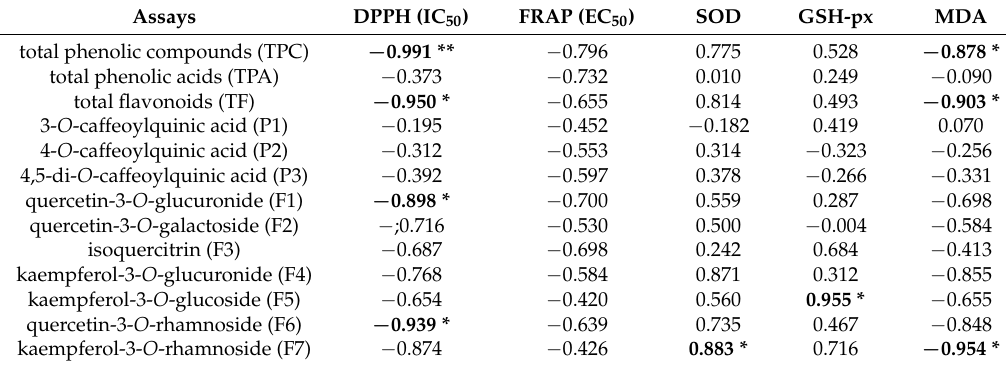
Table 3. Pearson correlation coefficients between phenolic compounds and antioxidant index ( n =